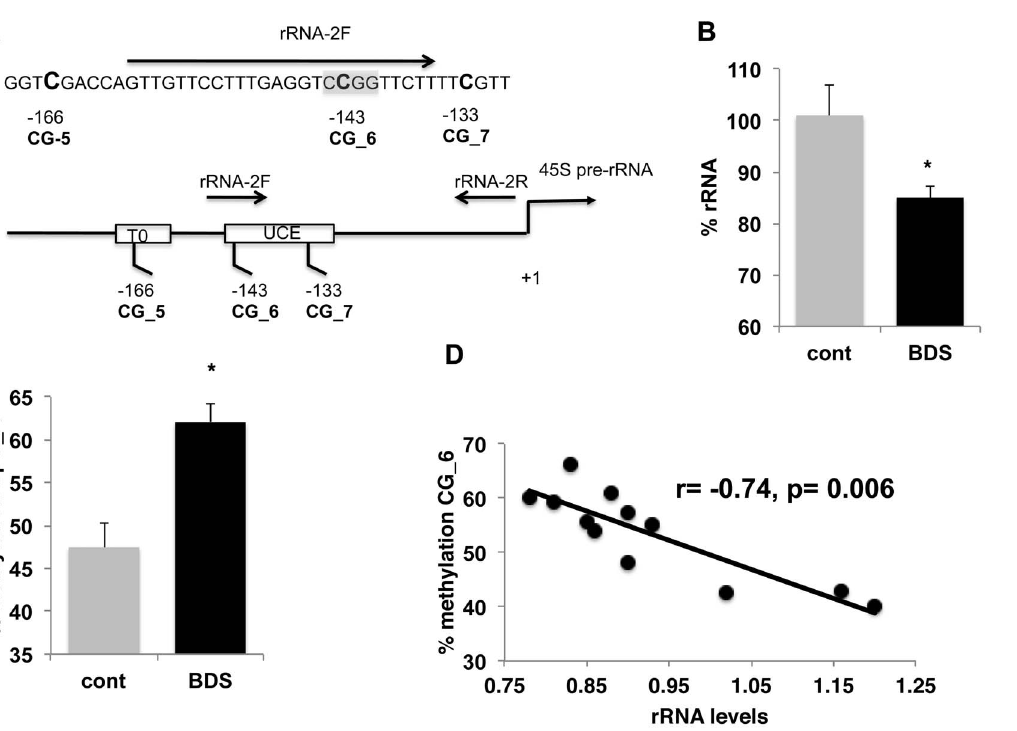
Fig. 4. PND14 pups exposed to BDS show increased methylation rate at CG_6 in a manner that is highly correlated with a decrease in rRNA levels. A (top) Nucleotide sequence of primer rRNA-2F (arrow) is shown with HpaII restriction site at CG_6 is highlighted in grey, (bottom), schematic diagram of Q- PCR primers used to assess DNA methylation at CG_6. Note that no product will be generated if CG_6 is not methylated and the DNA is digested with HpaII. Exposure to BDS decreases rRNA levels (B) while increasing DNA methylation at CG_6 in 14-day old pups (C). D. Levels of methylation at CG_6 are inversely correlated with rRNA levels in the developing hippocampus. Unpaired Student t tests (B, C), Pearson correlation (D). Error bars represent mean ¡ SEM, *p ,